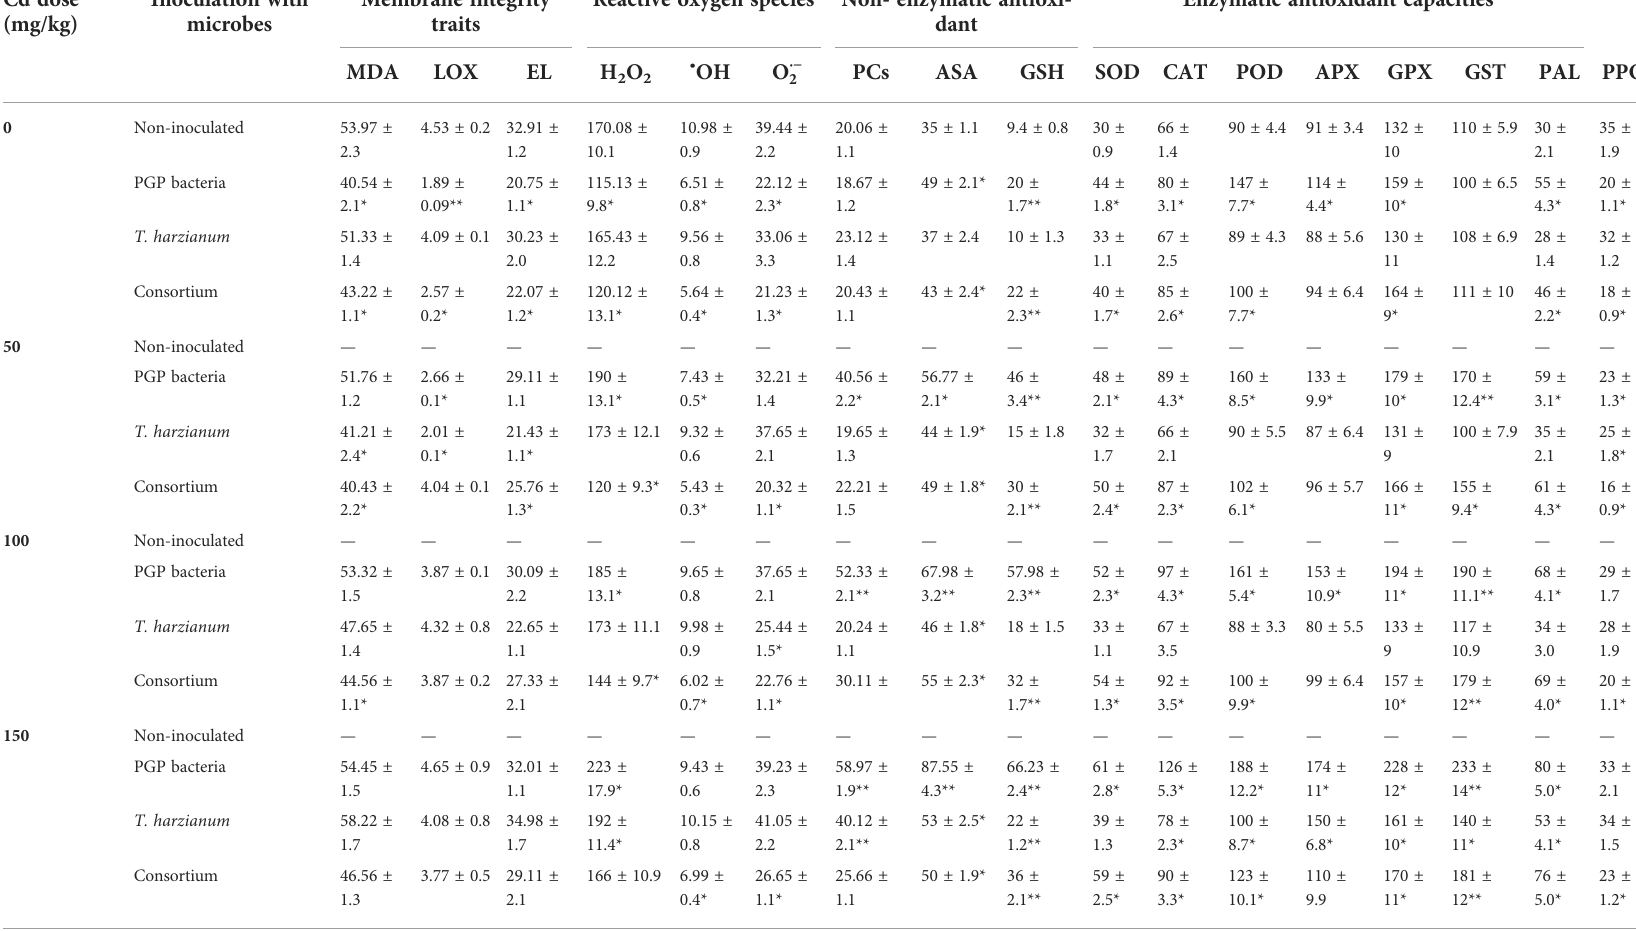
TABLE 4 Average values of some biochemical indices of sun fl ower inoculated and non-inoculated with PGP bacteria, T. harzianum , and Consortium and affected by different levels of Cd (0, 50, 100, and 150 mg/kg of soil). Cd dose